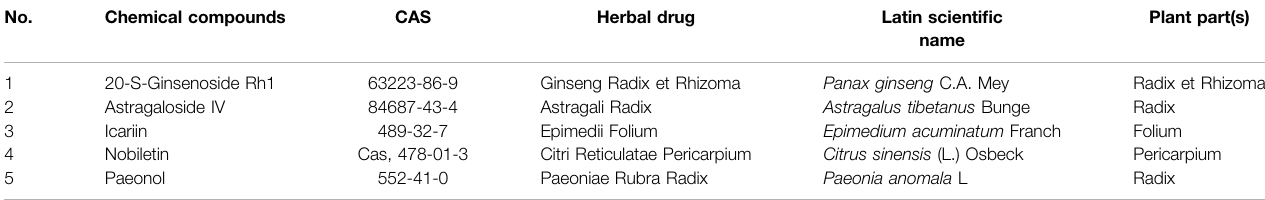
TABLE 2 | Plant source of fi ve chemical compounds.